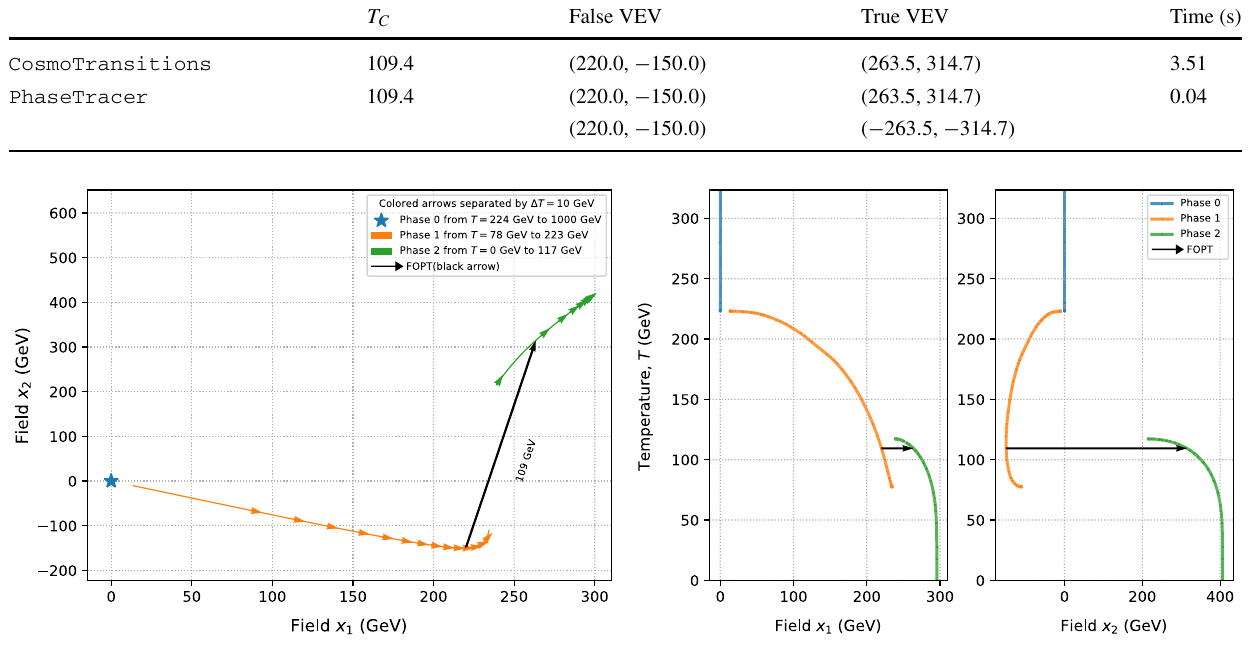
Fig. 3 Phase structure of the 2D test model. In the left panel, the changes in field values at a particular minimum with decreasing tem- perature are indicated by colored arrows in steps of (cid:4) T = 10GeV. The star represents a phase that does not change with temperature. The